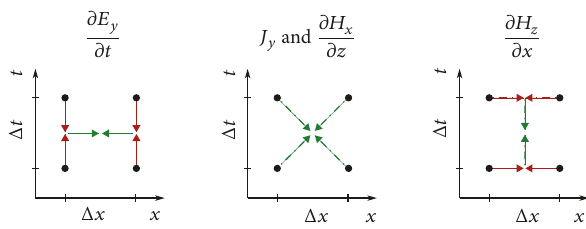
Figure 2: Visualization of the difference method applied to the Maxwell equation 𝜀 𝜕 𝑡 𝐸 𝑦 + 𝐽 𝑦 = 𝜕 𝑧 𝐻 𝑥 − 𝜕 𝑥 𝐻 𝑧 . The black dots represent the field samples in the (𝑥,𝑡) -space, the red arrows are differences, and the green arrows are interpolations. All terms are evaluated with second-order accuracy in the midpoint of the rectangle formed by the four sample